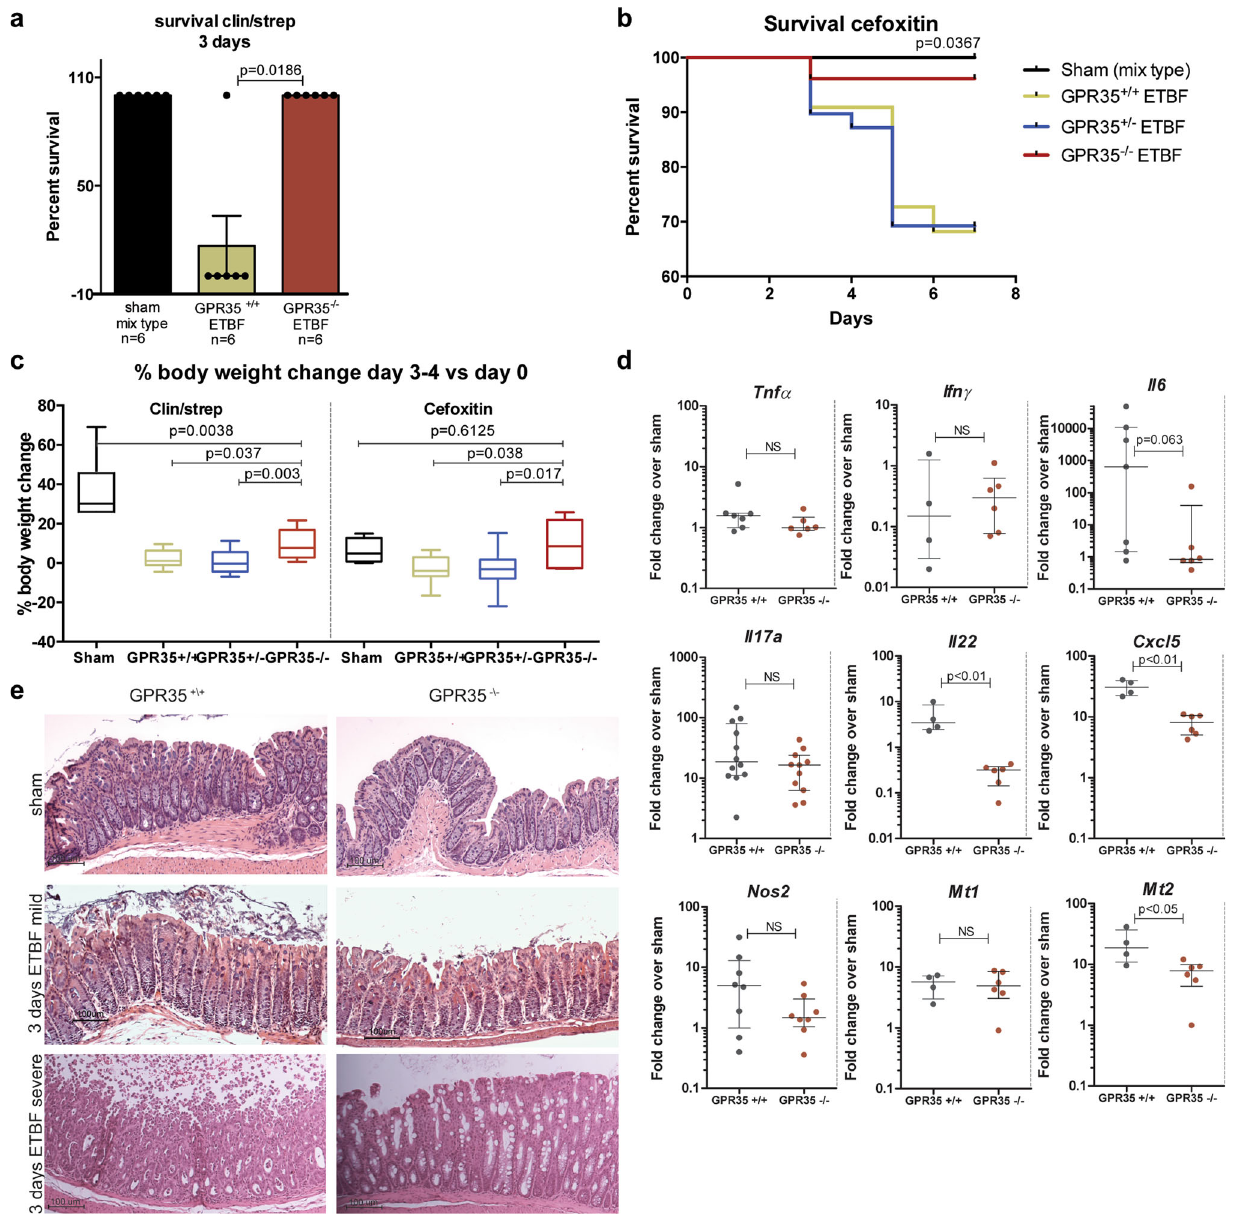
Fig. 6 GPR35-knockout mice show reduced lethality and less severe colitis after ETBF colonization. a Percentage survival of clin/strep pretreated GPR35 + / + (WT) and GPR35 − / − mice in a severe colitis experiment 3 days post ETBF infection ( P = 0.0186) ( N = 6 each). b Percentage survival of cefoxitin-treated GPR35 + / + (WT) ( N = 22), GPR35 + / − ( N = 39), and GPR35 − / − ( N = 26) mice over 7 days post ETBF colonization ( P = 0.0367). c Mouse body weight change in cefoxitin and clin/strep-treated mice. Body weights of GPR35 + / + (WT), GPR35 + / − , and GPR35 − / − mice were compared 3 days after ETBF colonization to their own baseline (day 0). Sham ( N = 6 and N = 4), GPR35 + / + ETBF ( N = 9 and N = 7), GPR35 + / − ETBF ( N = 22 and N = 15), and GPR35 + / − ETBF ( N = 7 and N = 6) for Clin/Strep and Cefoxitin models, respectively. d ) Il17a , Nos2 , Il22 , Cxcl5 , Il6 , Ifn- γ , Tnf - α , Mt1 , and Mt2 expression in the distal colon of GPR35 + / + and GPR35 − / − ETBF-colonized mice compared to their sham controls at 3 days post colonization. Signi fi cant differences were observed for Il22 , Cxcl5 , and Mt2 . Individual mice are represented in each dot. e H&E-stained sections of mouse distal colons from clin/ strep pretreated GPR35 + / + and GPR35 − / − mice at 3 days post ETBF colonization compared to the sham. Mild and severe ETBF colitis histology are shown in GPR35 + / + mice with corresponding GPR35 − / −